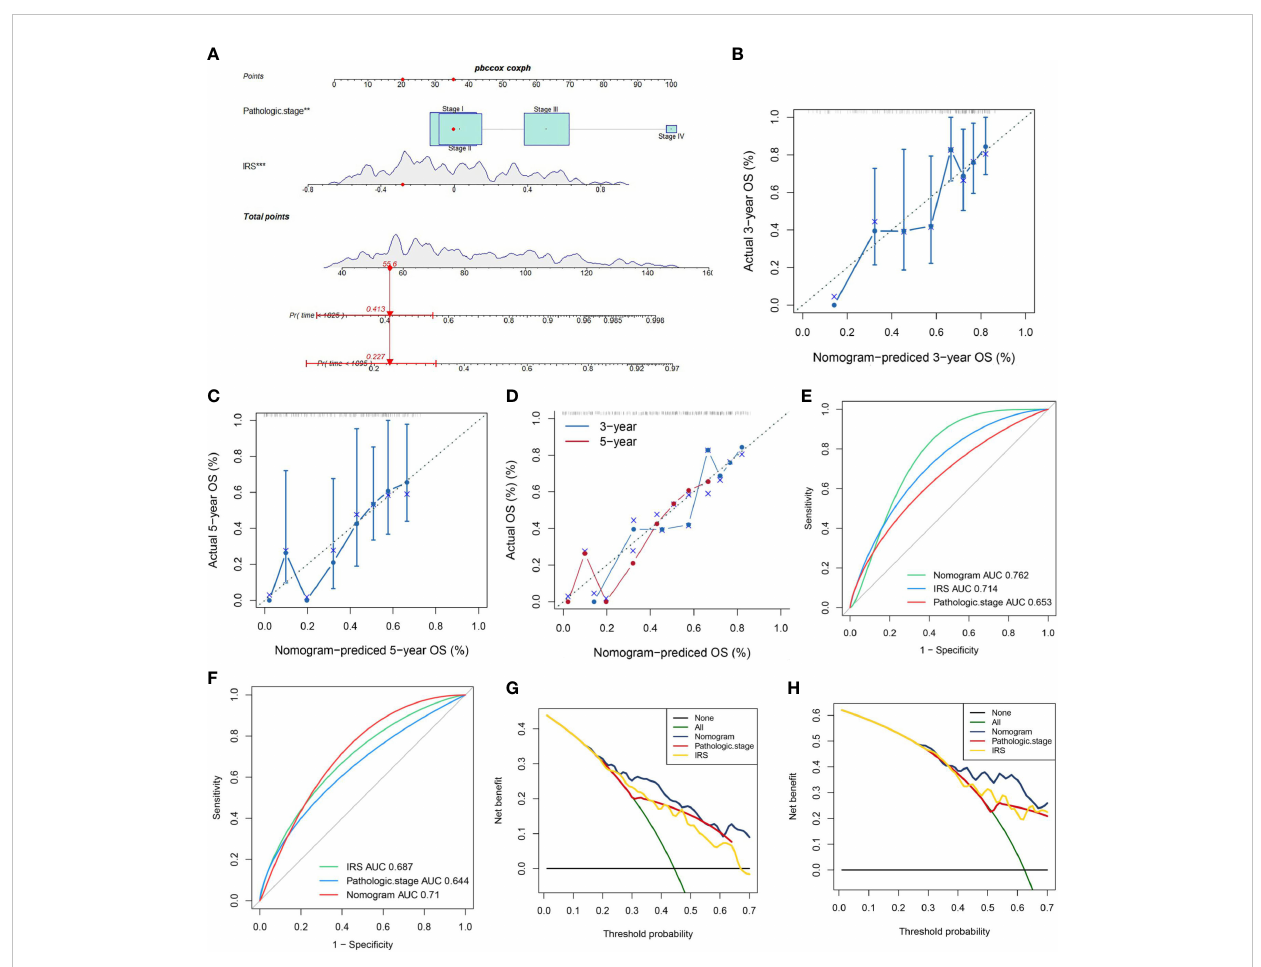
FIGURE 6 A Nomogram model ’ s Construction. (A) Nomogram combining pathological stage and risk score predicts 3-, and 5-years overall survival. (B – D) Calibration curves test the agreement between actual and predicted results at 1, 3, and 5 years. (E, F) Clinicopathological features and the predictive accuracy of the nomograms compared for 3 − , and 5 − year OS in virus-related HCC, respectively. (G, H) The DCA curves of the nomograms at 3 − , and 5 − year OS in HCC,